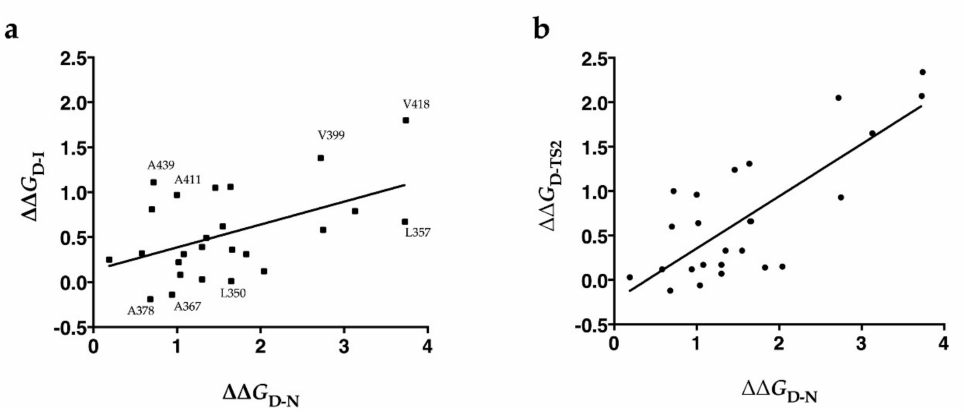
Figure 4. Bronsted plots for intermediate ( a ) (squares) and transition state two ( b ) (dots). In ( a ) the residues above/below the general trend for ∆∆ G D-I (see text) are also highlighted. The R values are 0.47 and 0.77, respectively, and the slope values are 0.25 and 0.6,